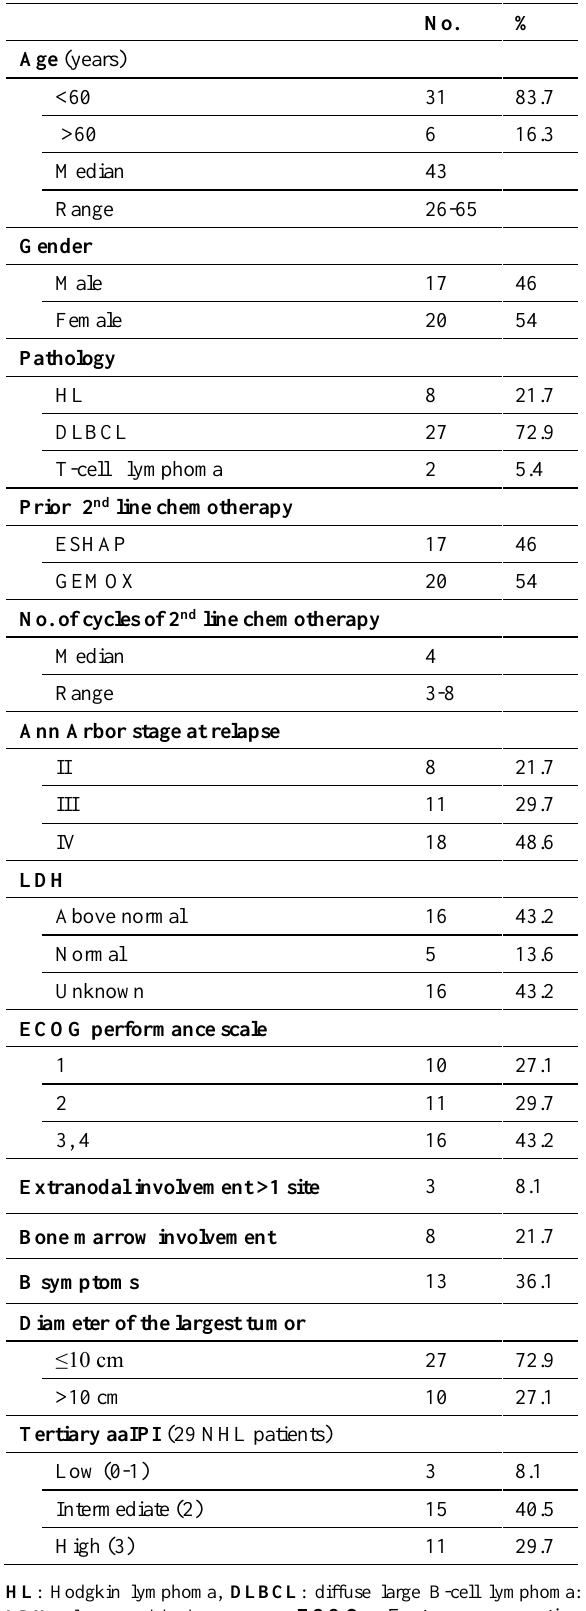
Table 1. Characteristics of 37 lymphoma patients who failed 2 nd line